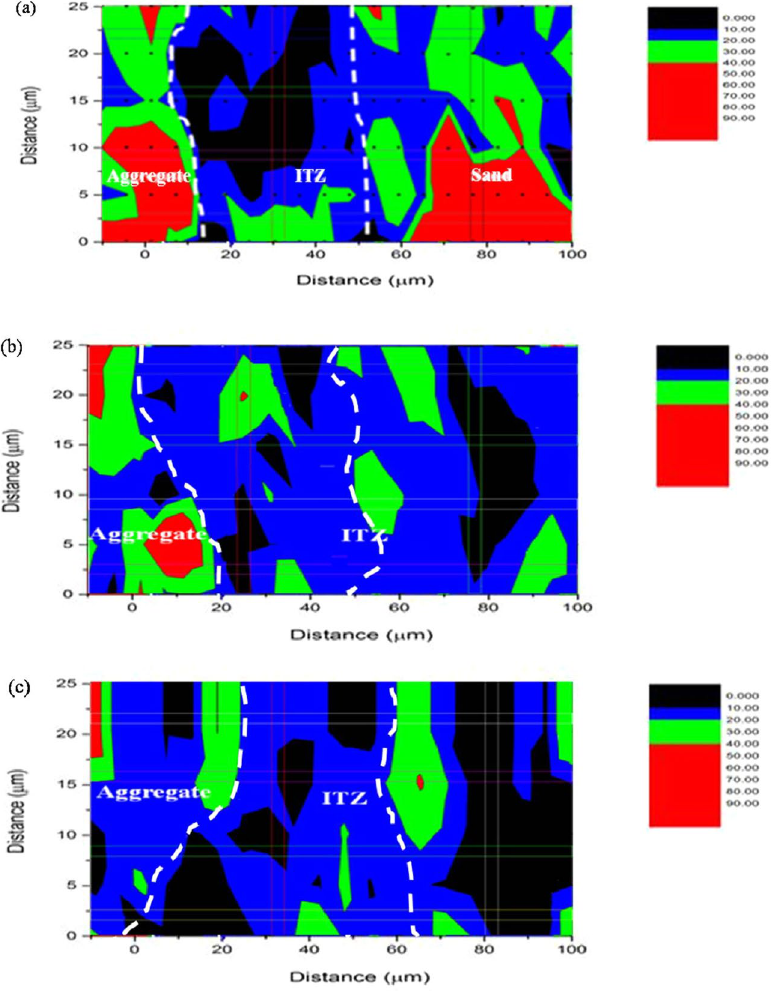
Figure 11. Contour map of ITZ thickness with 0, 700, and 1500 cycles 39 .